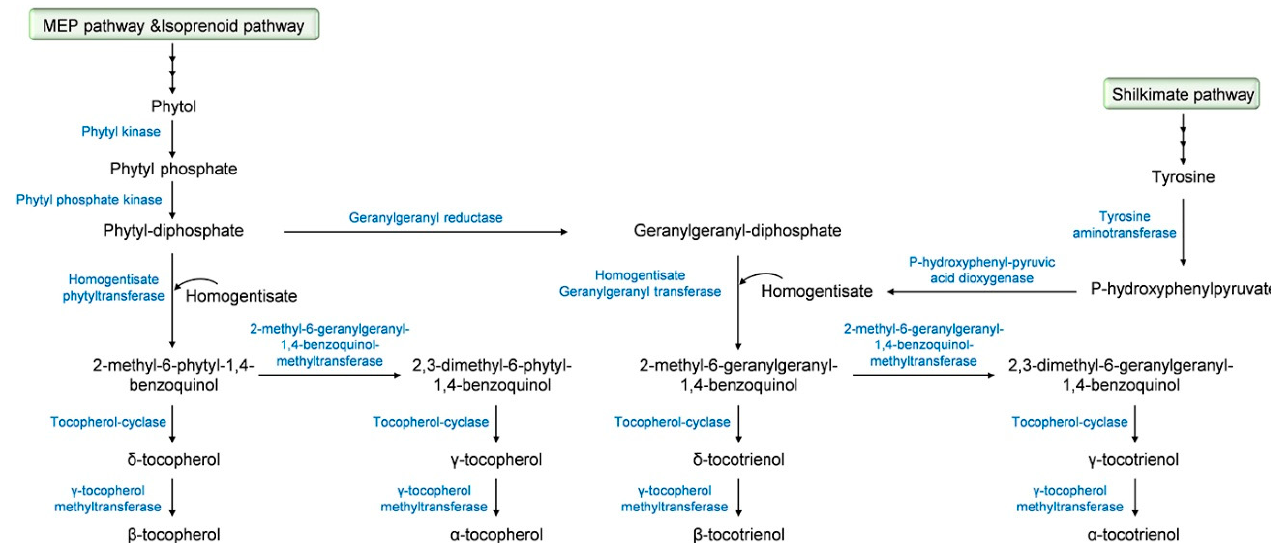
Figure 2. Tocochromanol biosynthetic pathway.